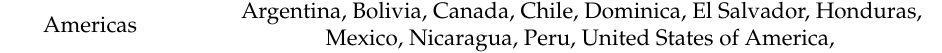
Table 1. List of countries affected by arsenic contamination in water [2–5]. Americas